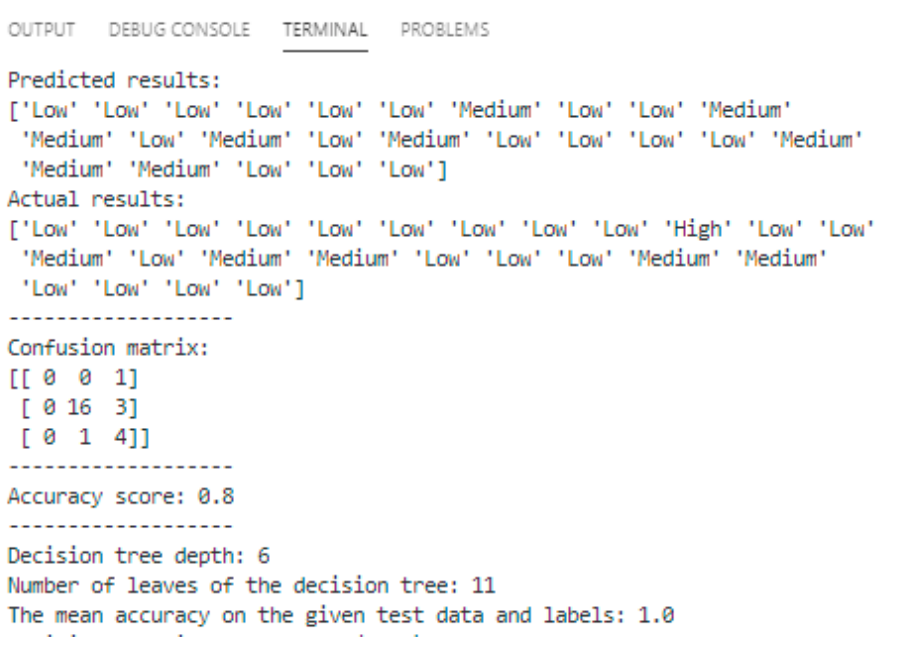
Figure 8. Performing the solution adequacy check.